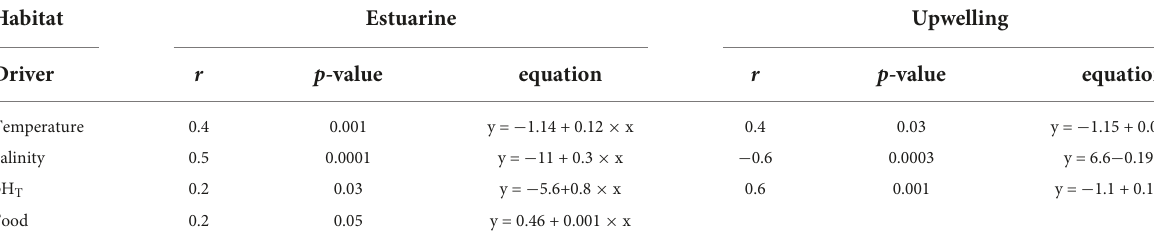
TABLE 4 Significant correlations (i.e., phenotypic plasticity) between EPE and environmental drivers for each population.